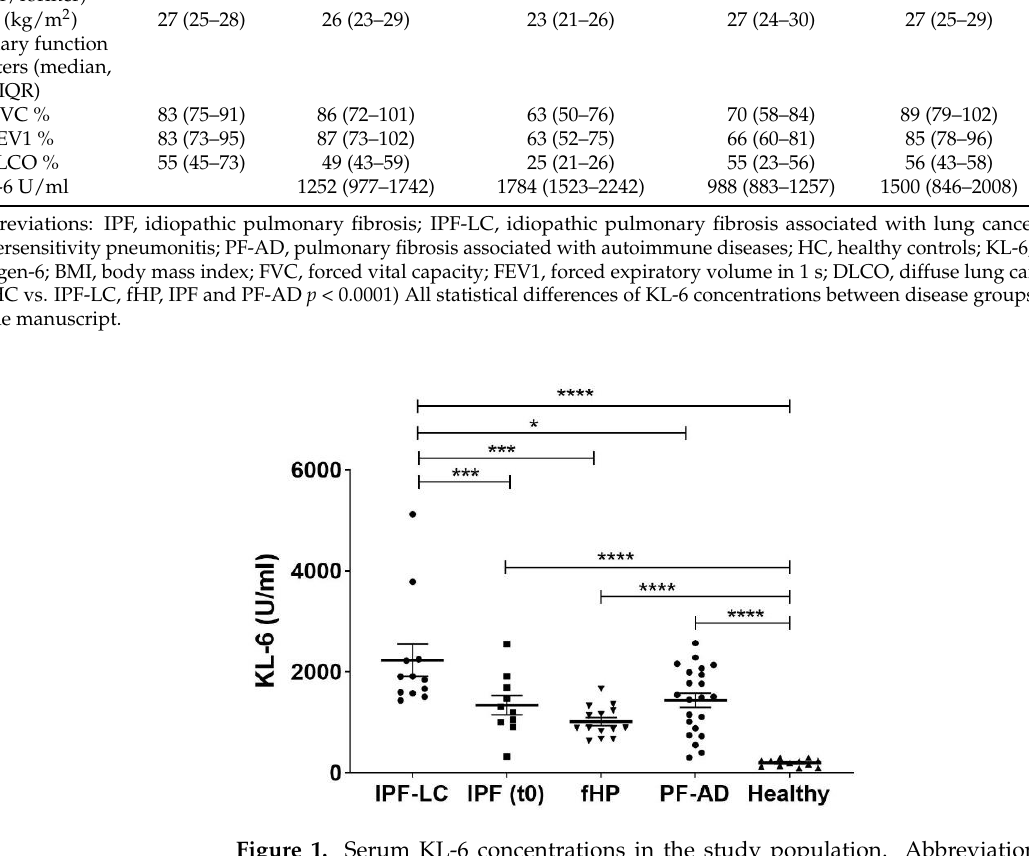
Figure 1. Serum KL-6 concentrations in the study population. Abbreviations: IPF, idiopathic pulmonary fibrosis; IPF-LC, idiopathic pulmonary fibrosis associated with lung cancer; fHP, fibrotic hypersensitivity pneumonitis; PF-AD, pulmonary fibrosis associated with autoimmune diseases; HC, healthy controls; KL-6, Krebs von den Lungen-6. * p < 0.05; *** p < 0.02; **** p < 0.0001. Table 2. Area under the receiver operating characteristics curve were performed between disease groups and healthy